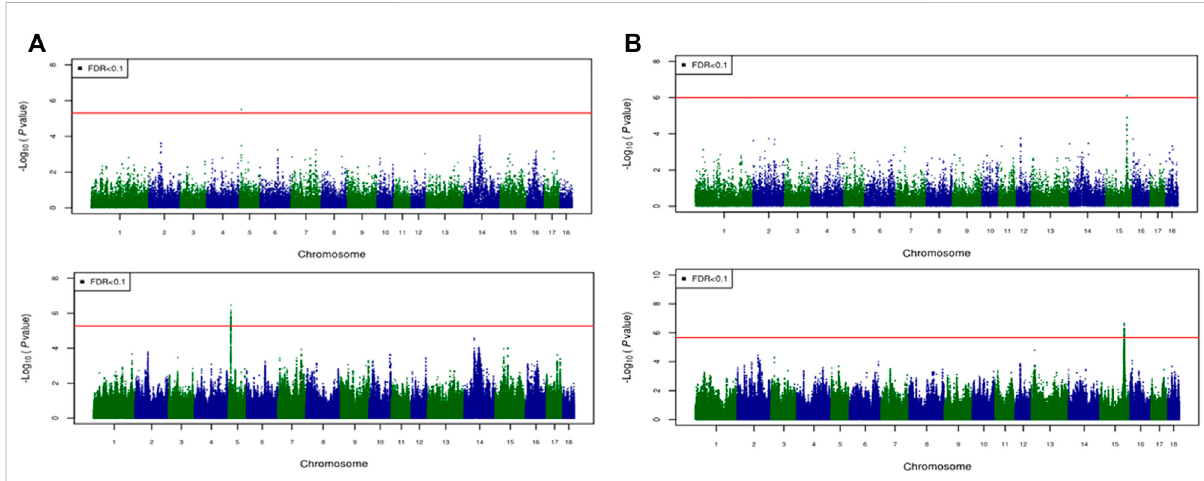
FIGURE 4 AssociatedregionsdetectedbyGWASforcrossbredpigs.Manhattanplotsfor: (A) TMCOLAand (B) GMCOLBusinga61Kmedium-densitypanel (top Figure) and WGS (bottom Figure). The -log10 p -values of single-SNP association along the entire genome are plotted against the genomic position of SNPs along the 18 autosome chromosomes. The SNPs associated with the corresponding traits exceeded the signi fi cance threshold at false discovery rate (FDR) of 0.1, having signi fi cant effects.